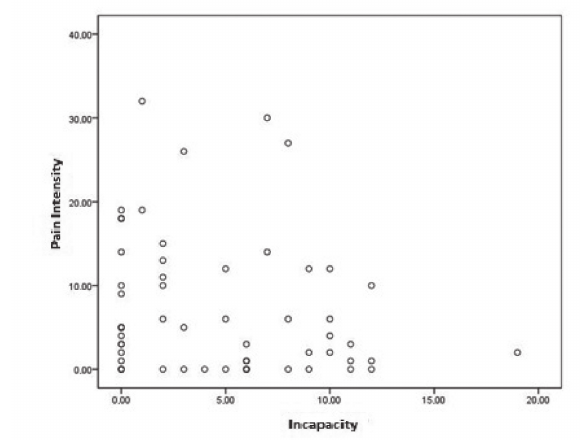
Figure 2 - Correlation among pain intensity and functional incapacity in construction workers. São Luis,